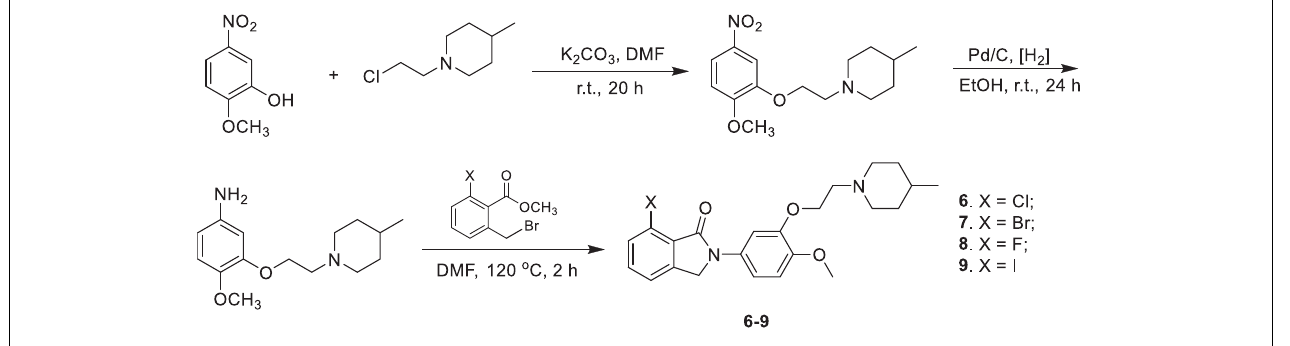
SCHEME 1 | Synthesis of 7-halogen